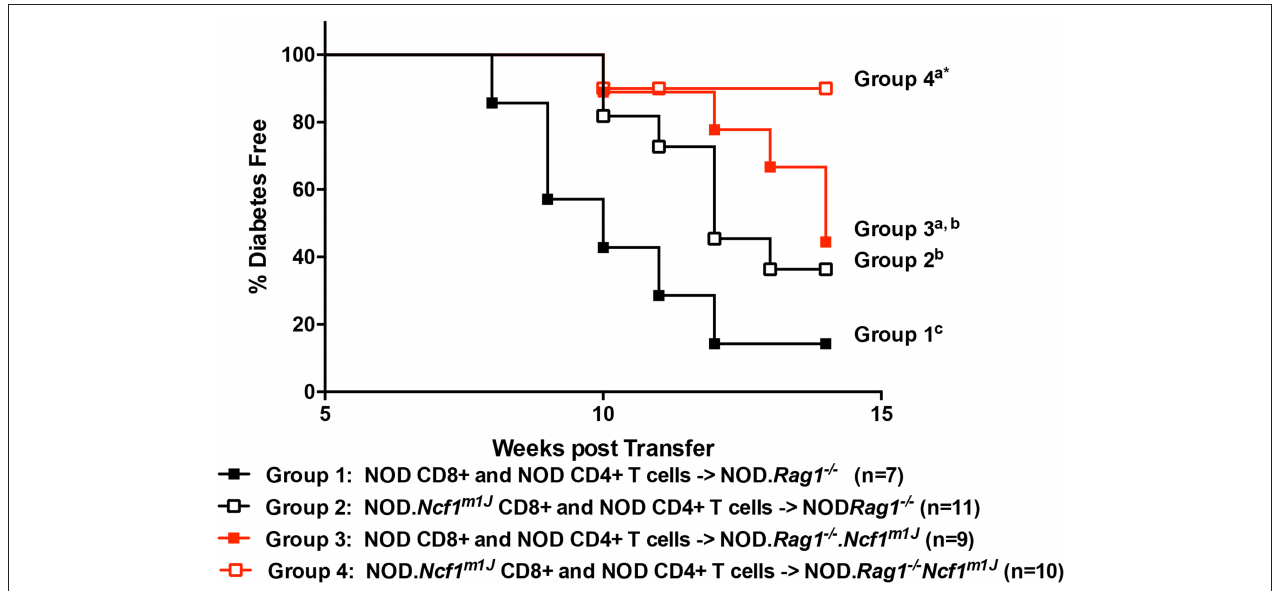
FIGURE 1 | A functional Ncf1 is essential in both CD8 + T cells and the environment for full T1D pathogenesis. Purified NOD CD4 + T cells were co-transferred with purified CD8 + T cells from either NOD (closed symbols) or NOD. Ncf1 m1J (Open symbols) at a 3:1 ratio. All donors were 8-week-old prediabetic mice. A total of 10 7 total T cells were injected i.p. into NOD. Rag1 − / − (black) or NOD. Rag1 − / − . Ncf1 m1J (red) recipient female mice. Mice were monitored by glucosuria for the onset of diabetes and confirmed by blood glucose measurement. Mice were considered diabetic after two consecutive readings of blood glucose above 250 mg/dL. *Letters denote significance: groups/lines with different letters were statistically significant, whereas those with the same letter were not statistically different. Table 1 contains p -values for the comparisons amongst groups.